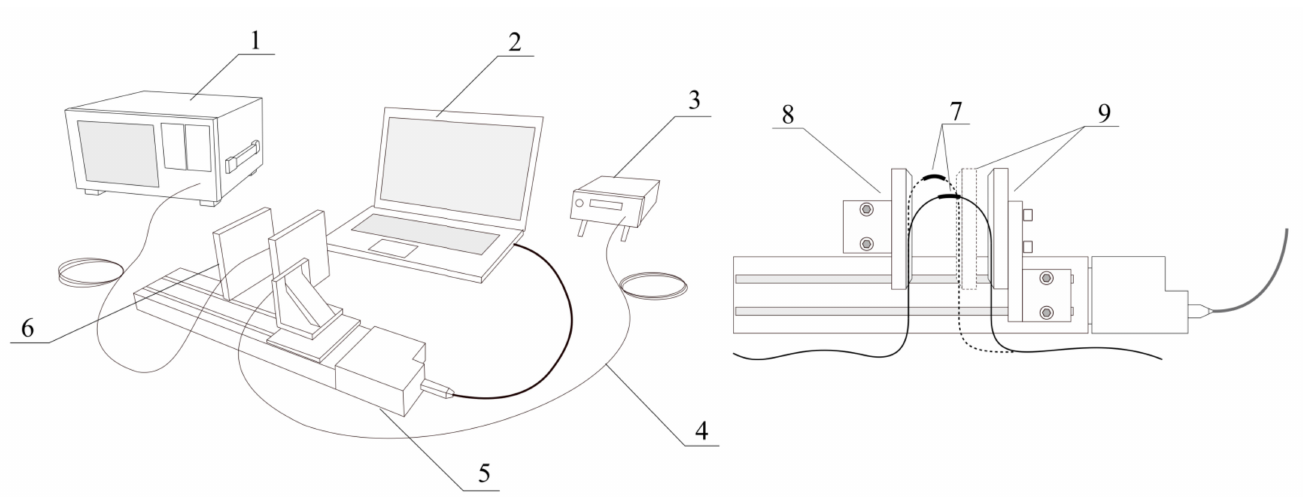
Figure 3. Scheme of the measuring system and the method of forcing the curvature of the fibre where: 1—optical spectrum analyser, 2—PC computer, 3—SLED broadband source, 4—single mode optical fibre, 5—automated micro-translation stage, 6—bending adjustment: 7—optical fibre section with TFBG inscribed, 8—fixed optical stage plate, 9—translation stage